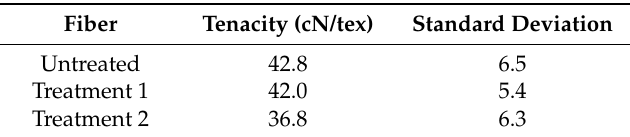
Table 4. Banana fiber tenacity.